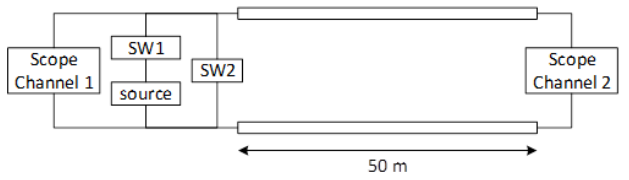
Figure 25. Schematic of the experimental setup.